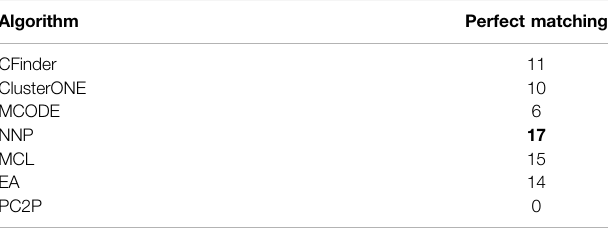
TABLE7| Numbersofproteincomplexesperfectlymatchedbyeachalgorithmfor DIP data set. Algorithm